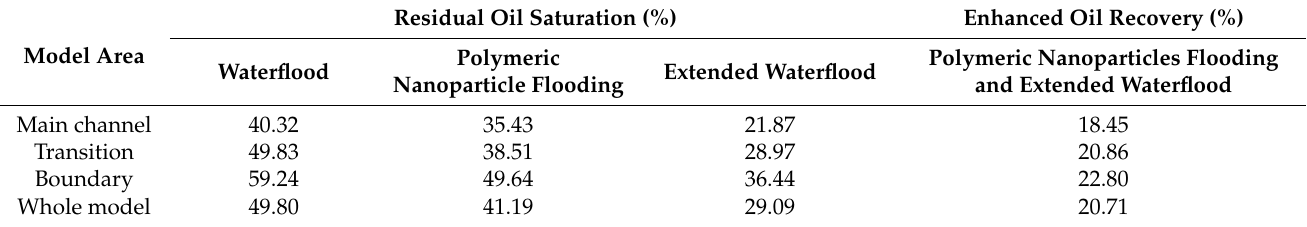
Table 2. Enhanced oil recovery at different sections of the